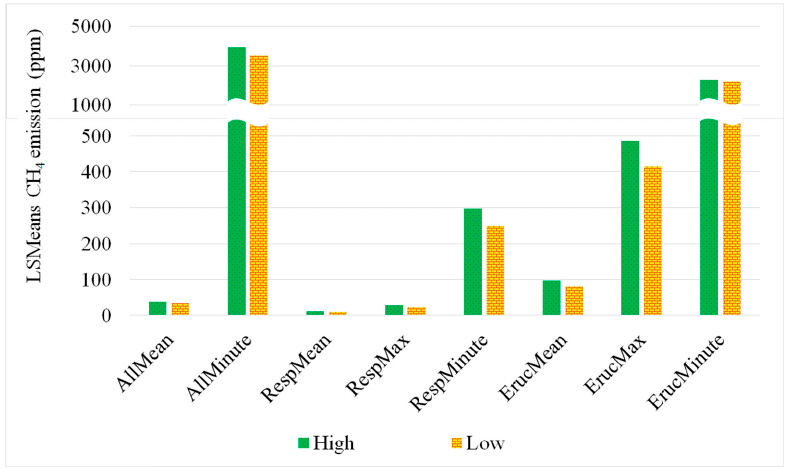
Figure 6. Least square means (LSMeans) for the methane traits subjected to a high (High) and a low (Low) neutral detergent fiber intake